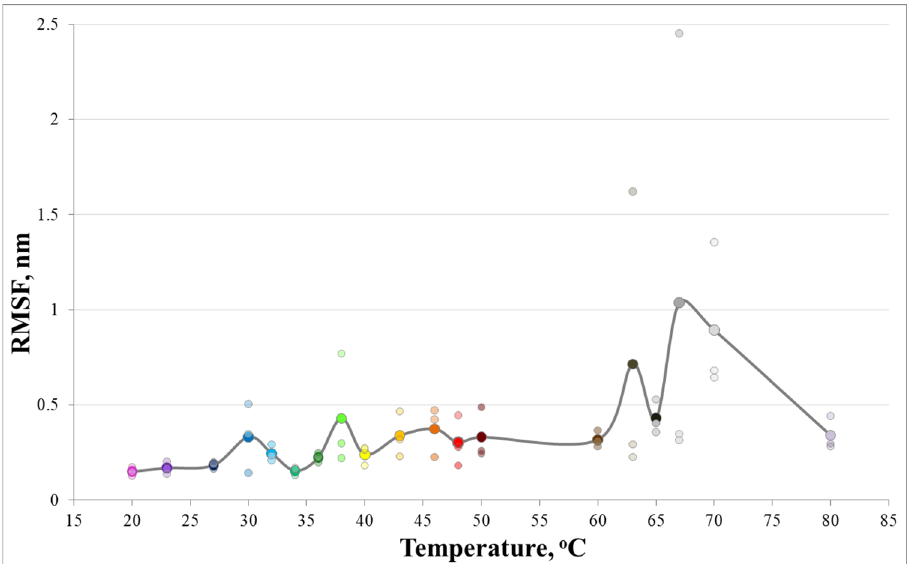
Figure 4. RMSF of proteinase K dimers averaged over C α atoms at different temperatures (from 20 to 80 °C). Saturated connected points represent data averaged over three independent simulations marked by unsaturated points.